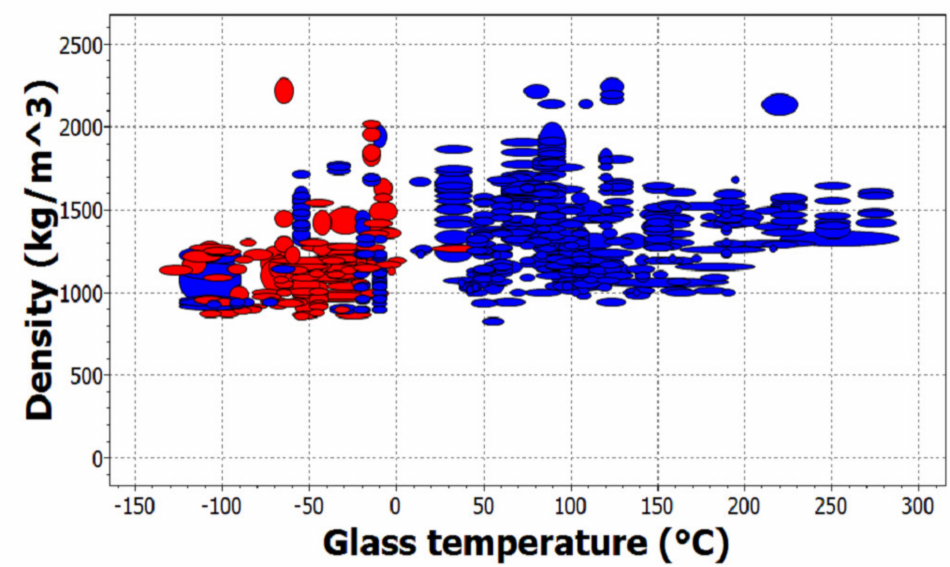
Figure 5. Example of a material chart obtained in the CES EduPack